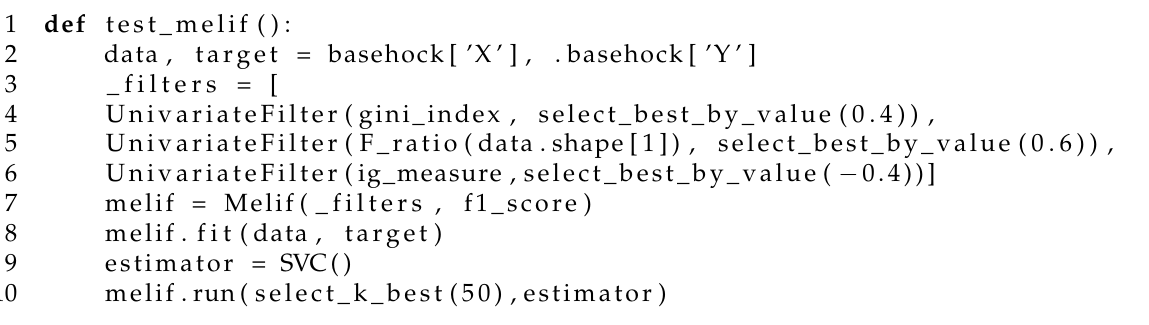
Listing 8. Example of ensemble algorithm MeLiF usage.